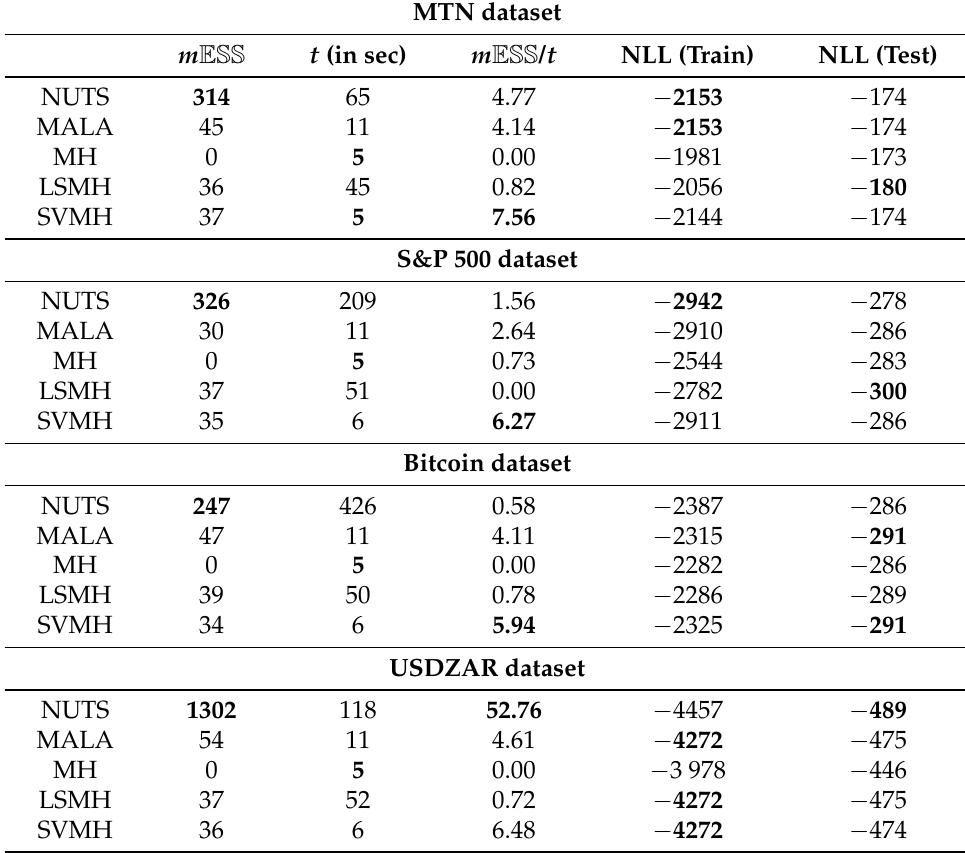
Table 3. Results averaged over thirty runs of each method for the jump diffusion process datasets. Each row corresponds to the results for a specific method for each performance metric. NLL is the negative